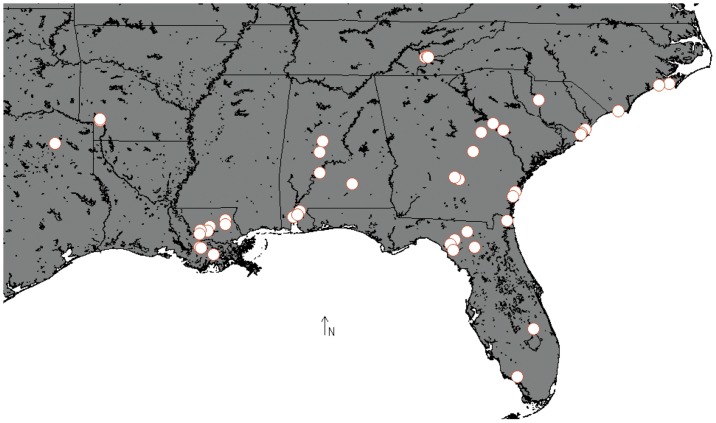
Sampling localities.